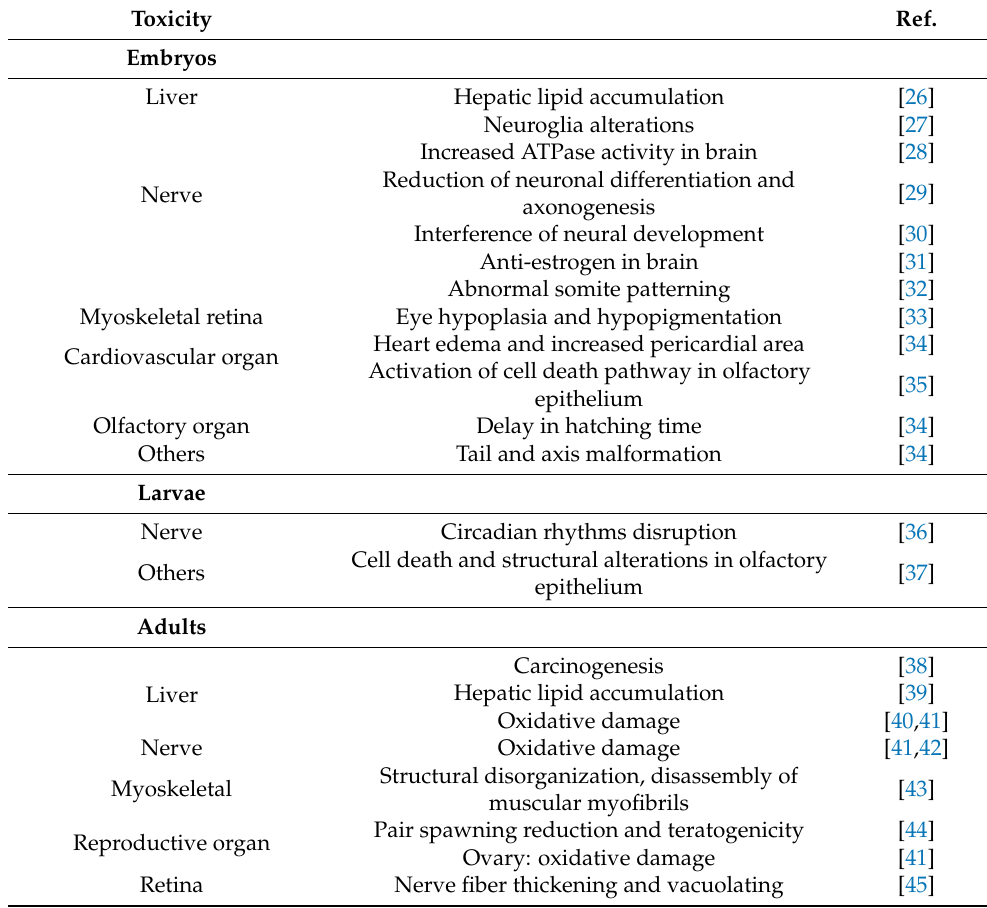
Table 2. Summary of toxic effects of cadmium in zebrafish. Reproduced with permission from [25]. Copyright 2021, Korean Society of